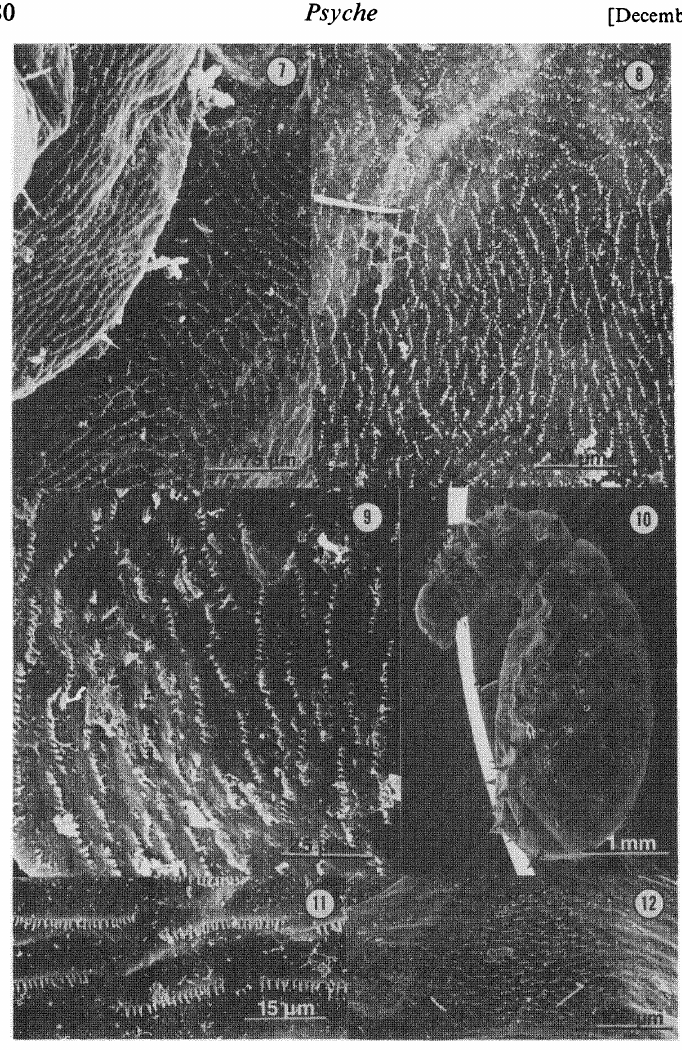
Figs. 7-12. Fig. 7. Pachycondyla villosa. Note semicircular pattern (lower right) of ventral prothoracic spinules. Portion of the left side of the head is also visible (left portion). Fig. 8. Posteroventral region of P. villosa showing circles of spinules of a segment. Fig. 9. High magnification of circles of spinules of posteroventral region of P. villosa. Fig. 10. Lateral view of Odontomachus clarus. Note posteroventral region (large arrow), and surrounding tubercles (small arrow). Fig. 11. Posteriorly pointing, ventral mesothoracic spinules of O. clarus. Fig. 12. Posteriorly pointing spinules of a segment of the posteroventral region of O.